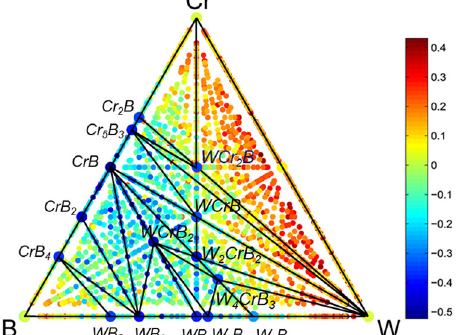
Fig. 3 Phase diagram of the W – Cr – B system. Energies of formation (in eV atom − 1 ) of the sampled structures of the W – Cr – B system at ambient pressure are shown. The color bar gives the scale of the energies of formation.